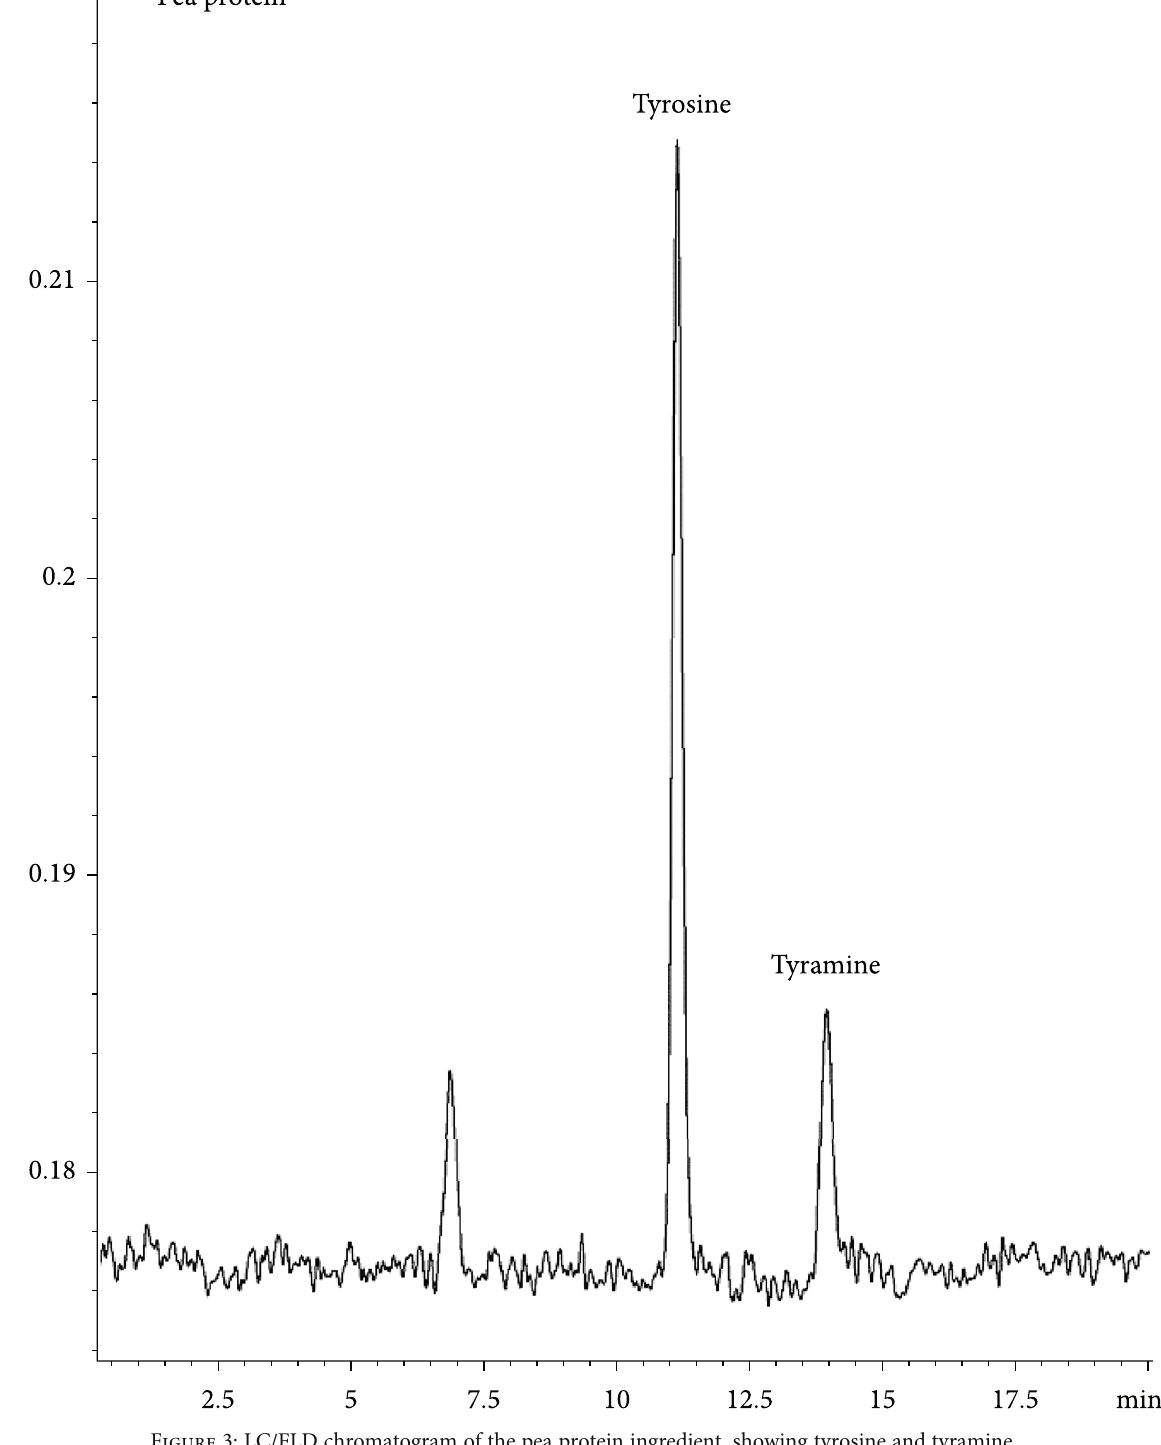
Figure 3: LC/FLD chromatogram of the pea protein ingredient, showing tyrosine and